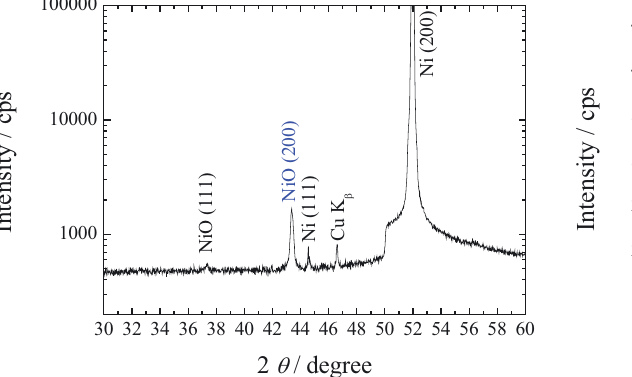
Figure 1. X-ray diffraction pattern of NiO on a textured Ni substrate formed at 800°C under argon with 3 ppm oxygen. Ni – radiation. filtered Cu K a